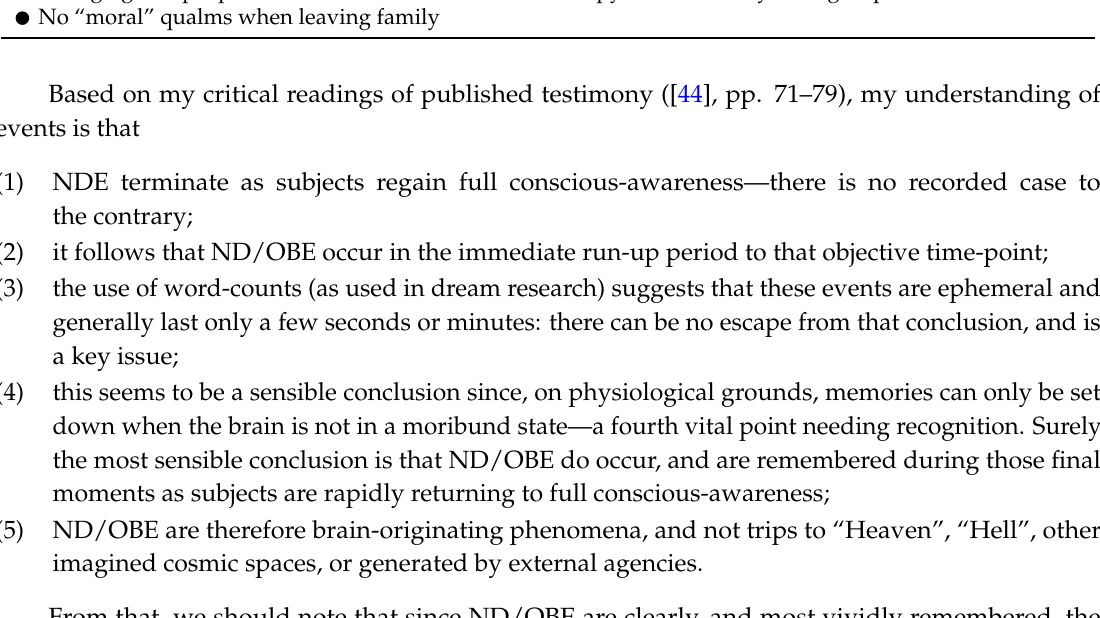
Table 1. I have dismissed the so-called “core” trajectory of ND/OBE as not being a true representation of what subjects have actually recalled, being more an artefact contrived in the minds of the authors reporting these events, as originally depicted by Moody [1]. That discrepancy is obviously revealed by the data displayed (Figure 1) above. A re-classification of ND/OBE as more reflective of what subjects have actually reported is summarised and classified into early-, and late-, phase experiences. NDE: Early & Late Phase No pain Increased pain perception Ability to traverse physical objects Hearing real voices Absence of gravity—floating/weightless “Moral” imperative to assume earthly responsibilities Sense of motion—acceleration/gyration Unable/unwilling to cross physical barriers Seeing light & people Bumpy return to